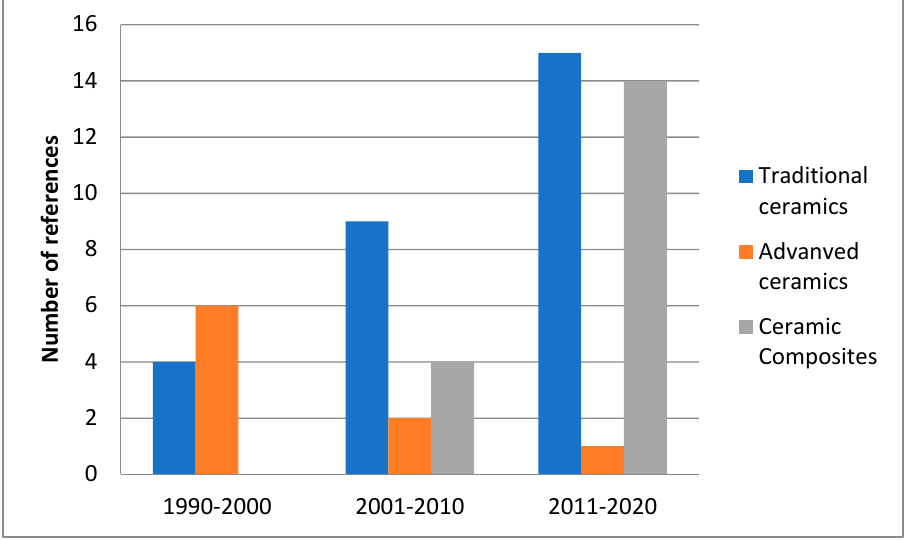
Figure 12. Scientific interest in time on different halloysite-based ceramics of the current review.